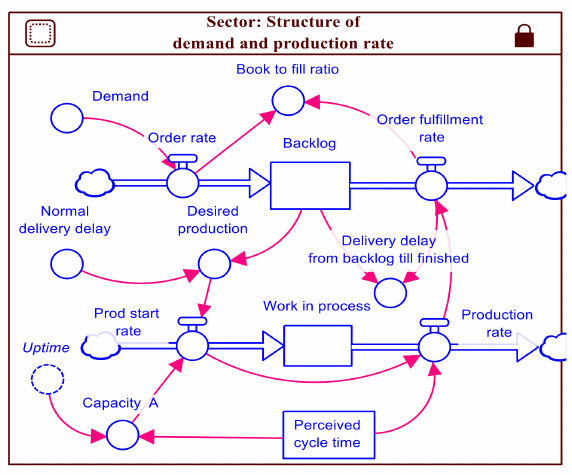
Figure 12. Structure of operational parameters